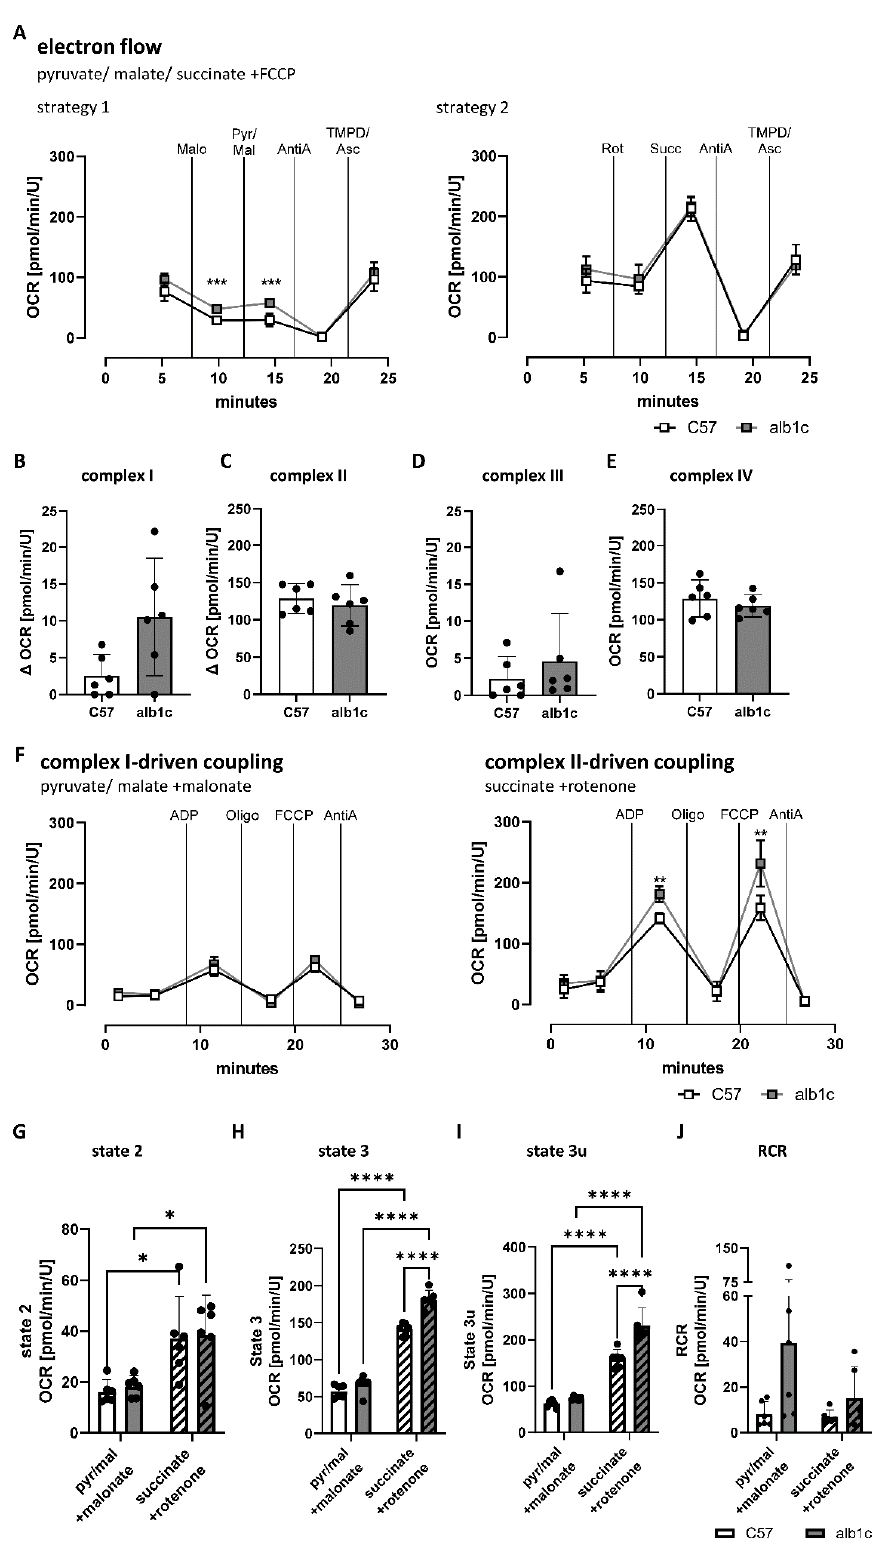
Figure 4. Electron flow capacity and coupling efficiency of mitochondrial ETC in alb-SREBP-1c